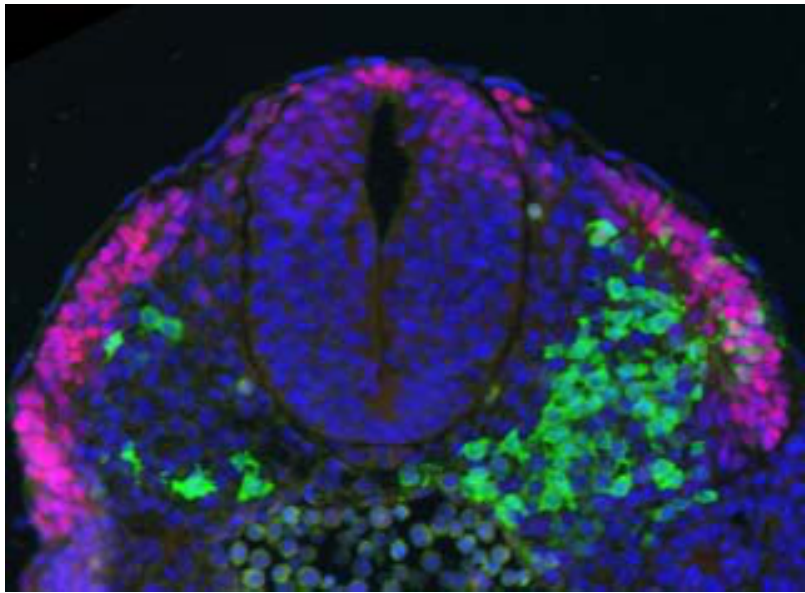
Figure 1. Stem cell–derived neuromesodermal precursors (green) transplanted into mouse embryos (shown in cross-section here) contribute to mesoderm, including Pax3